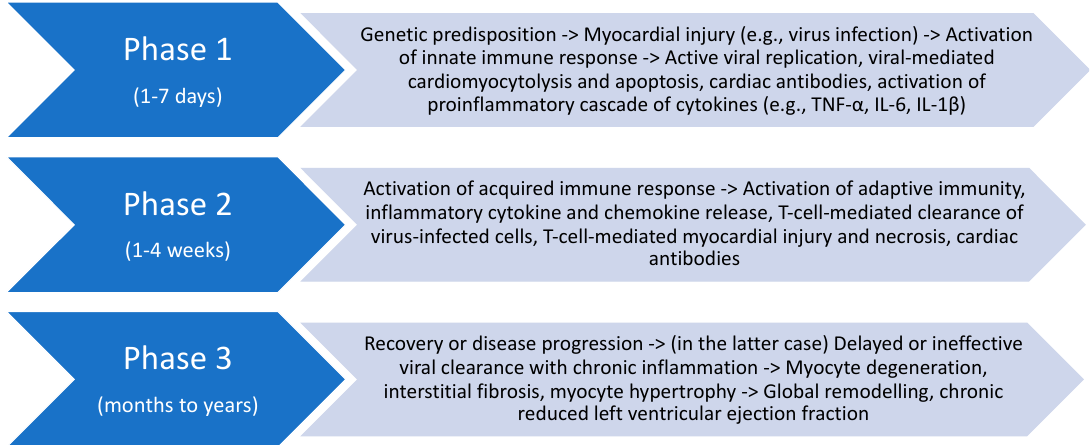
Figure 4. Schematic representation of the pathogenesis of dilated inflammatory cardiomyopathy. See text for details.